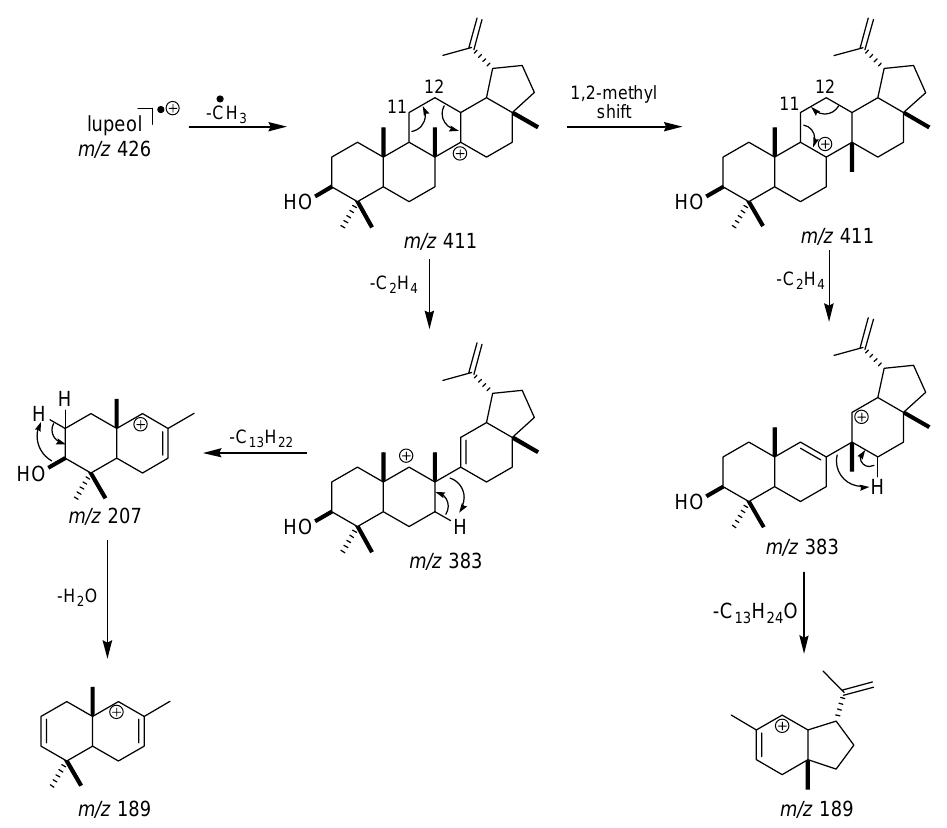
Figure 3. Formation of the fragment ions with m/z 207 and m/z 189, proposed with basis on